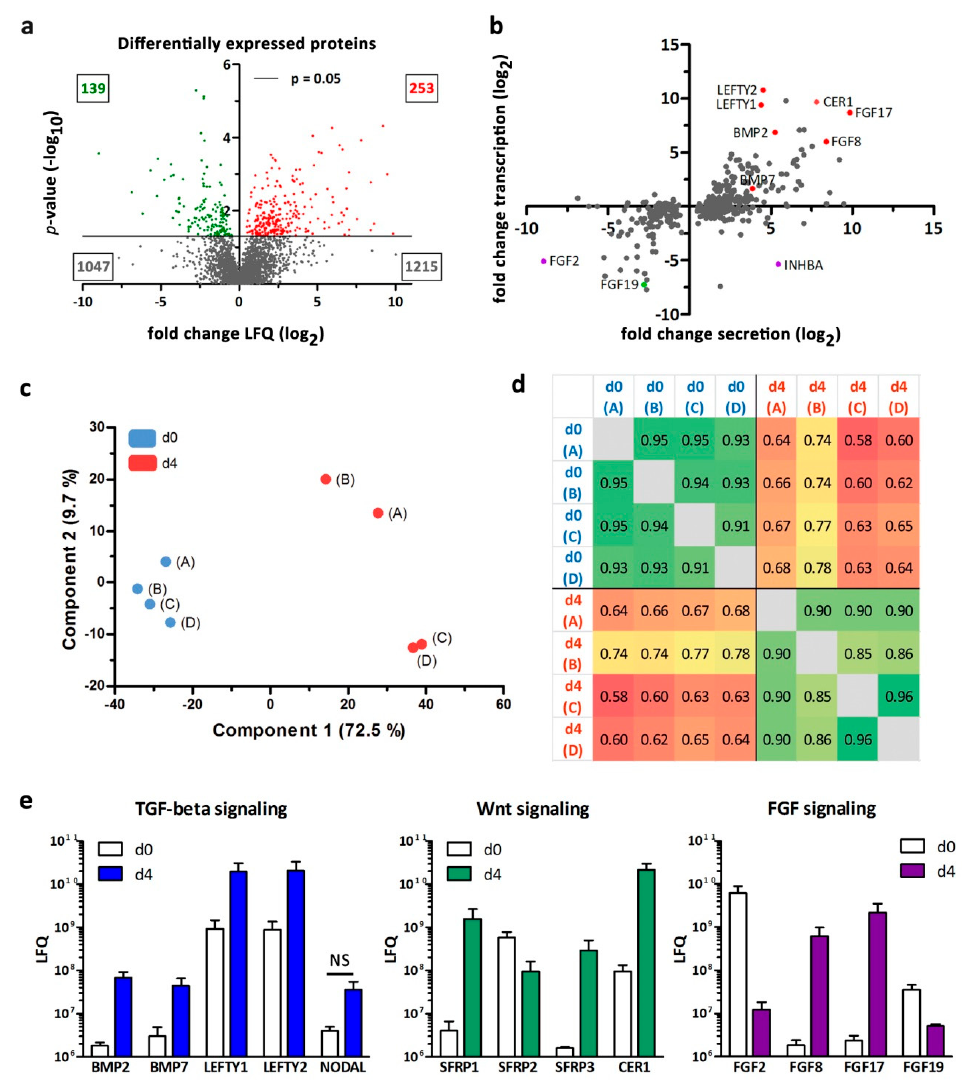
Figure 4. Assessment of secreted proteins by mass spectrometry. ( a ) Volcano plot of 2654 proteins (log2 of label-free quantification (LFQ) fold changes) identified in d0 and d4 cells. A total of 392 proteins were significantly altered ( p ≤ 0.05, 2 sample Student’s t -test). A total of 139 proteins were downregulated (green) and 253 proteins were significantly upregulated (red) in d4 compared to d0 samples. ( b ) Correlation of fold change secretion changes (log2) with fold change transcription changes (log2) in proteins/genes significantly altered at d4 compared to d0. Candidate genes from selected signaling pathways are highlighted. ( c ) Principal component analysis (PCA) of the 392 significantly altered proteins for four individual samples (A–D) at d0 (blue) and d4 (red), respectively. ( d ) Pearson correlation for four biological replicates (A–D) at d0 and d4, respectively. ( e ) Mean LFQ values of relevant secreted proteins in supernatants of d0 and d4 cells samples belonging to TGF-beta-, Wnt-, and FGF-signaling pathways. All proteins, except NODAL, were significantly changed ( p ≤ 0.05, two sample Student’s t -test) (SFRP3 = FRZB). Table 1. Secreted signaling factors in hESCs and definitive endoderm (DE) cells. Gene Names